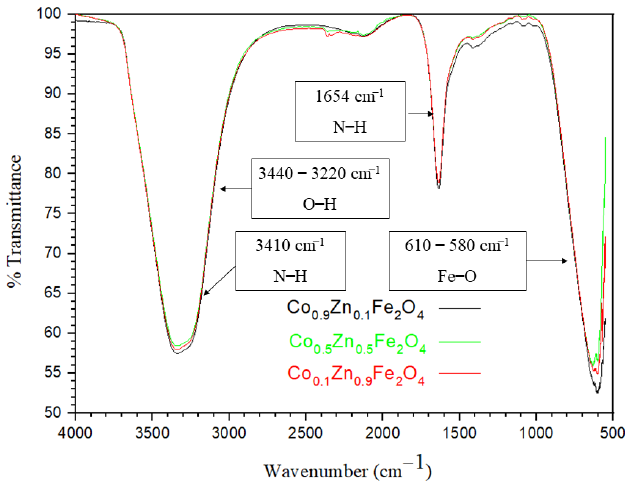
Figure 4. Fourier transform infrared spectroscopy (FTIR) spectra of chitosan-coated Co 1 − x Zn x Fe 2 O 4 with x = 0.1, 0.5 and 0.9 nanoparticles at a calcine temperature of 500 °C.